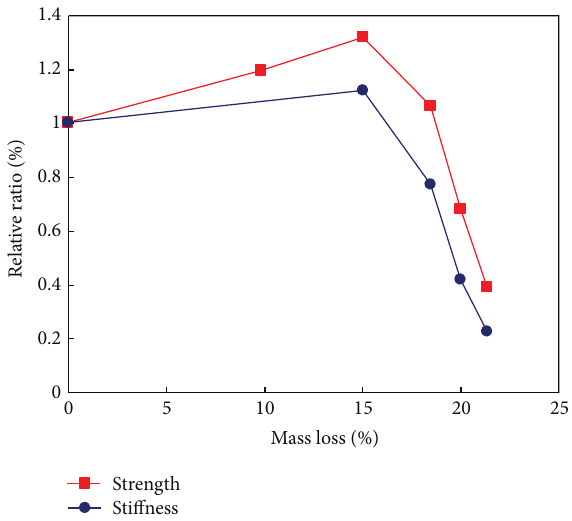
Figure 7: Relationships of strength and stiffness to mass